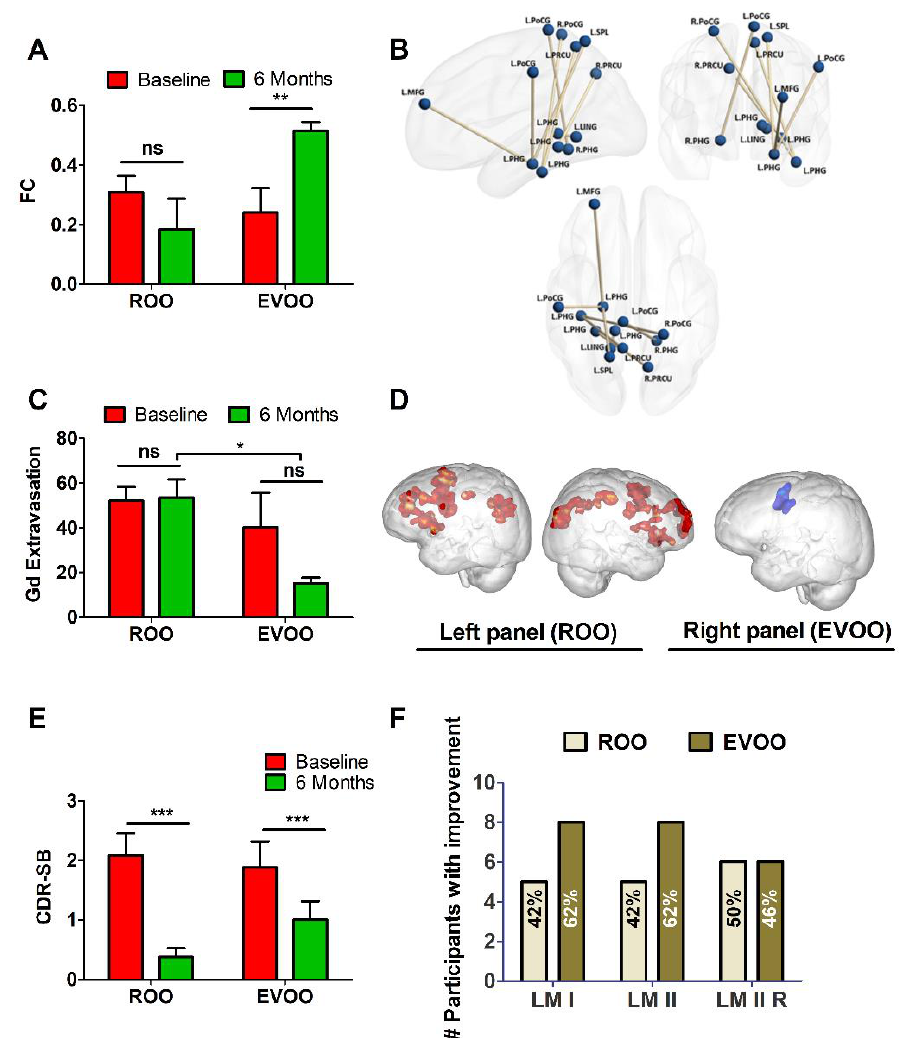
Figure 2. Findings from MRI screen. Effect of 6-month consumption of ROO and EVOO on ( A ) Functional connectivity (FC) for overall connections shown in Table 2. The baseline is shown in red and the 6-month timepoint is shown in green, with ( B ) Visualization of connections shown in Table 2. Abbreviation: Middle Frontal Gyrus (MFG), parahippocampal gyrus (PHG), precuneus (PRCU), Postcentral gyrus (PoCG), lingual gyrus (LING), superior parietal lobule (SPL). L: left and R: right ( n = 12 in each group); and ( C ) BBB permeability assessed as overall Gd extravasation in the hippocampus and PHG shown in Table 2. ( D ) Comparison of network variant locations between task and rest states. The left panel is for ROO group 6-month > baseline task-rest differences, and the right panel is for EVOO group baseline > 6-month task-rest differences. Please see Tables S1 and S2 for a list- ing of coordinates from the local maxima within the cluster for ROO and EVOO groups, respectively. Effect of 6-month consumption of ROO and EVOO on ( E ) CDR-SB, and ( F ) the number of participants who demonstrated improved learning memory (immediate and delayed) assessed by the WMS-IV logical memory test. Data are presented as mean + SD; ns is not significant, * p < 0.05, ** p < 0.01, *** p < 0.001 is a significant difference between baseline and 6 months post olive oil